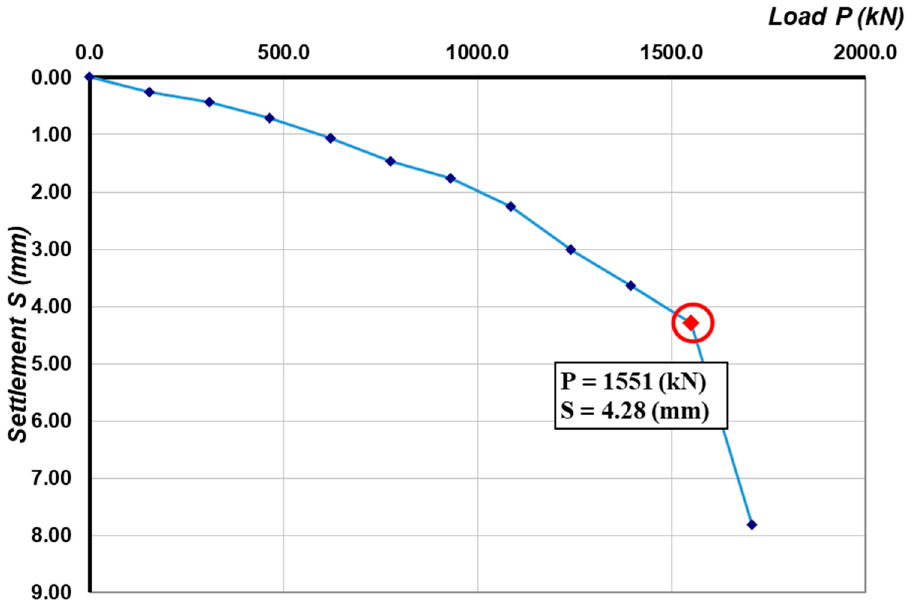
Figure A1. Load–settlement relationship for pile number P_511.